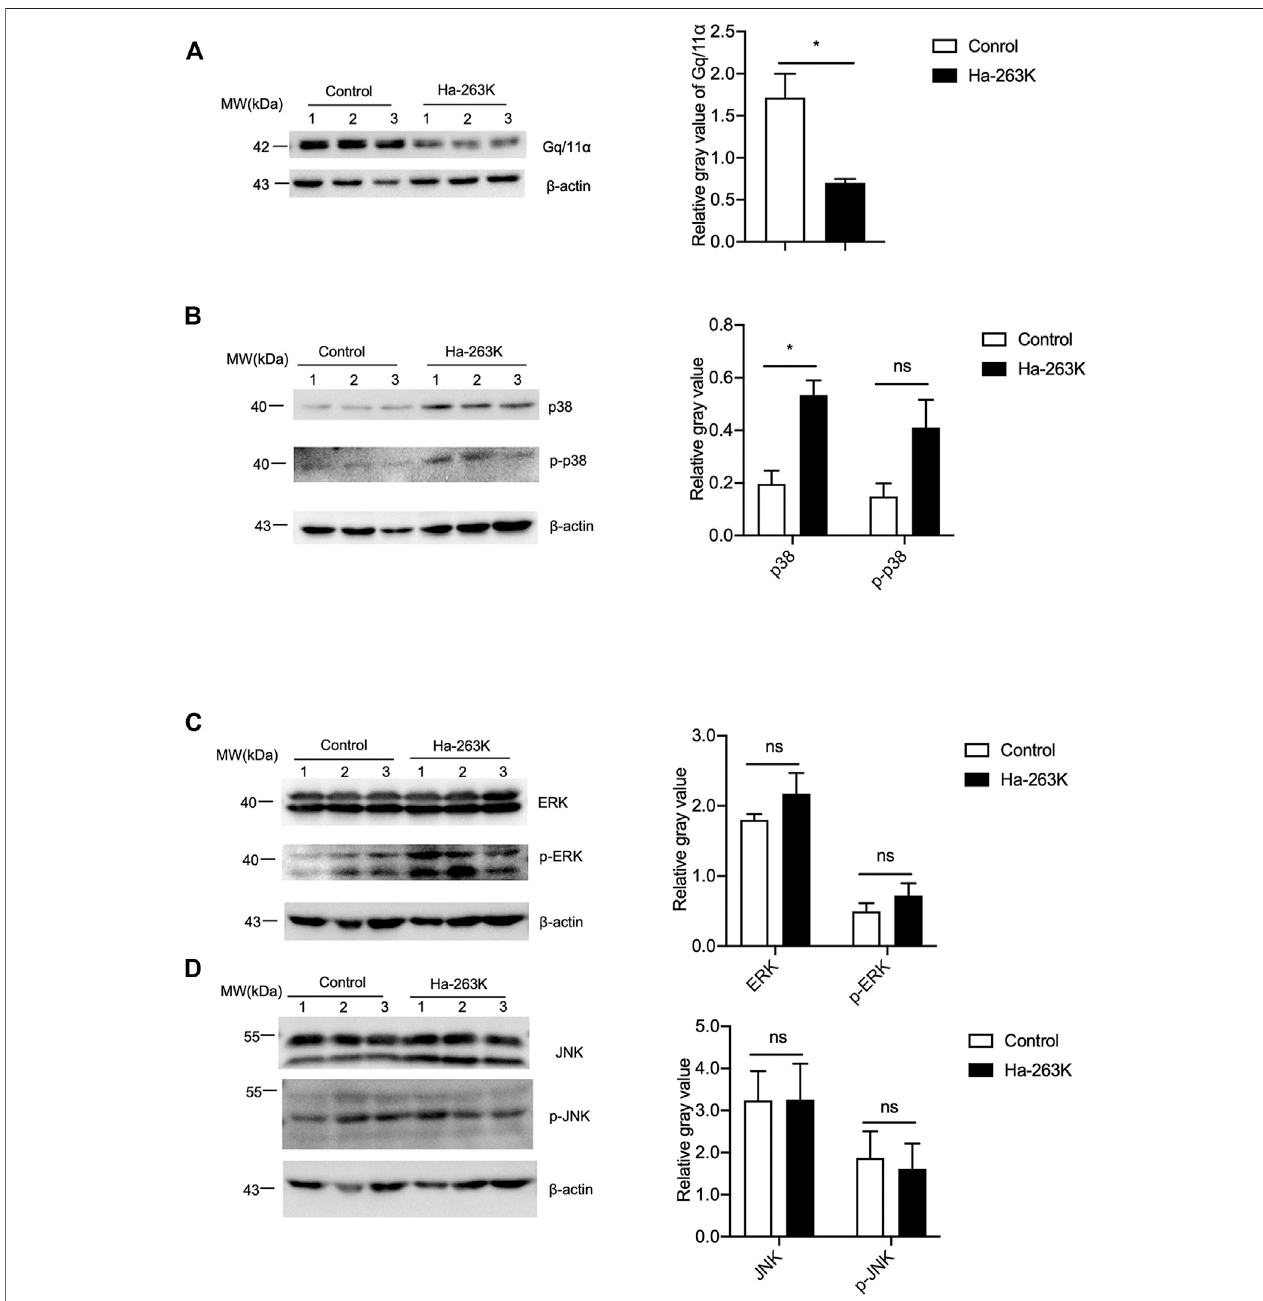
FIGURE8| ThelevelsofGPCRanddownstreamkinasesinthebraintissuesof263K-infectedhamsters. (A-D) Left: WesternblotsforthelevelsofGq/11 α (A) ,p38 andp-p38 (B) ,ERKandp-ERK (C) ,JNKandp-JNK (D) .Relativemolecularweightsaremarkedontheleft(1,2,3)indicatethenumberofreplicates. Right: Densitometric analyses of the average gray values of the signals of the target proteins after being equilibrated with that of β -actin.